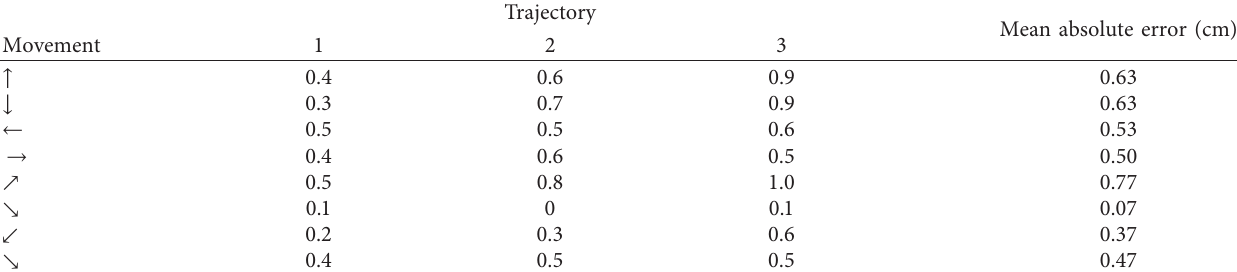
Table 4: Linear movement errors in the kinematic model.